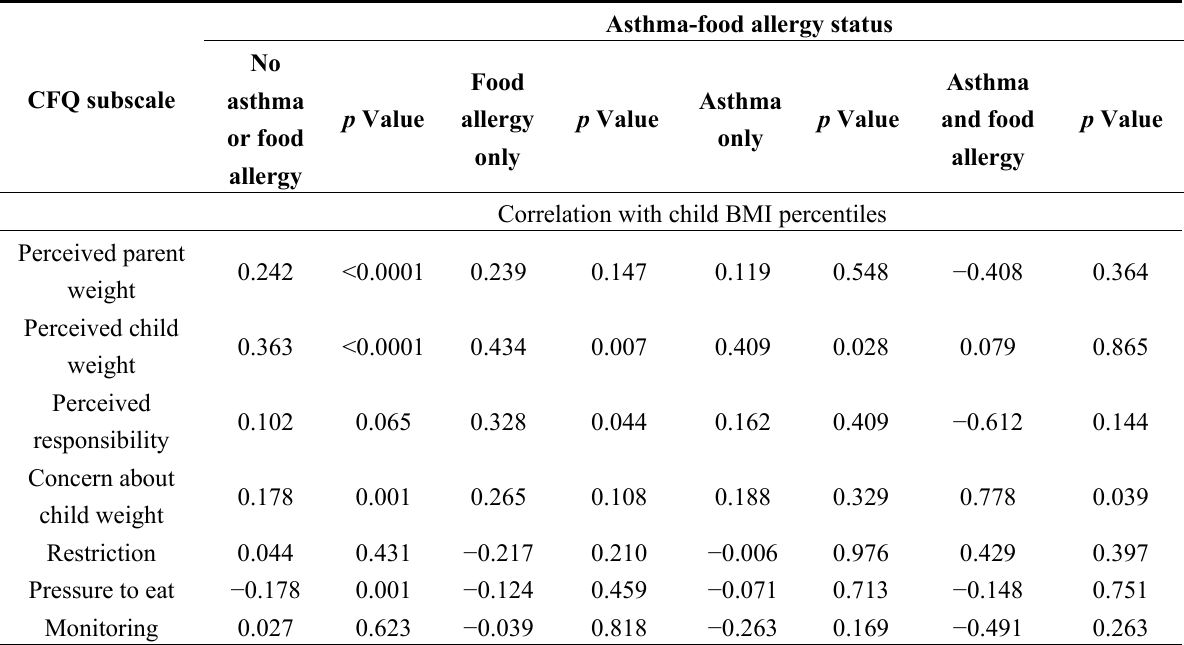
Table 4. Association of the CFQ subscales with child BMI percentiles using Spearman’s rank-order correlation.